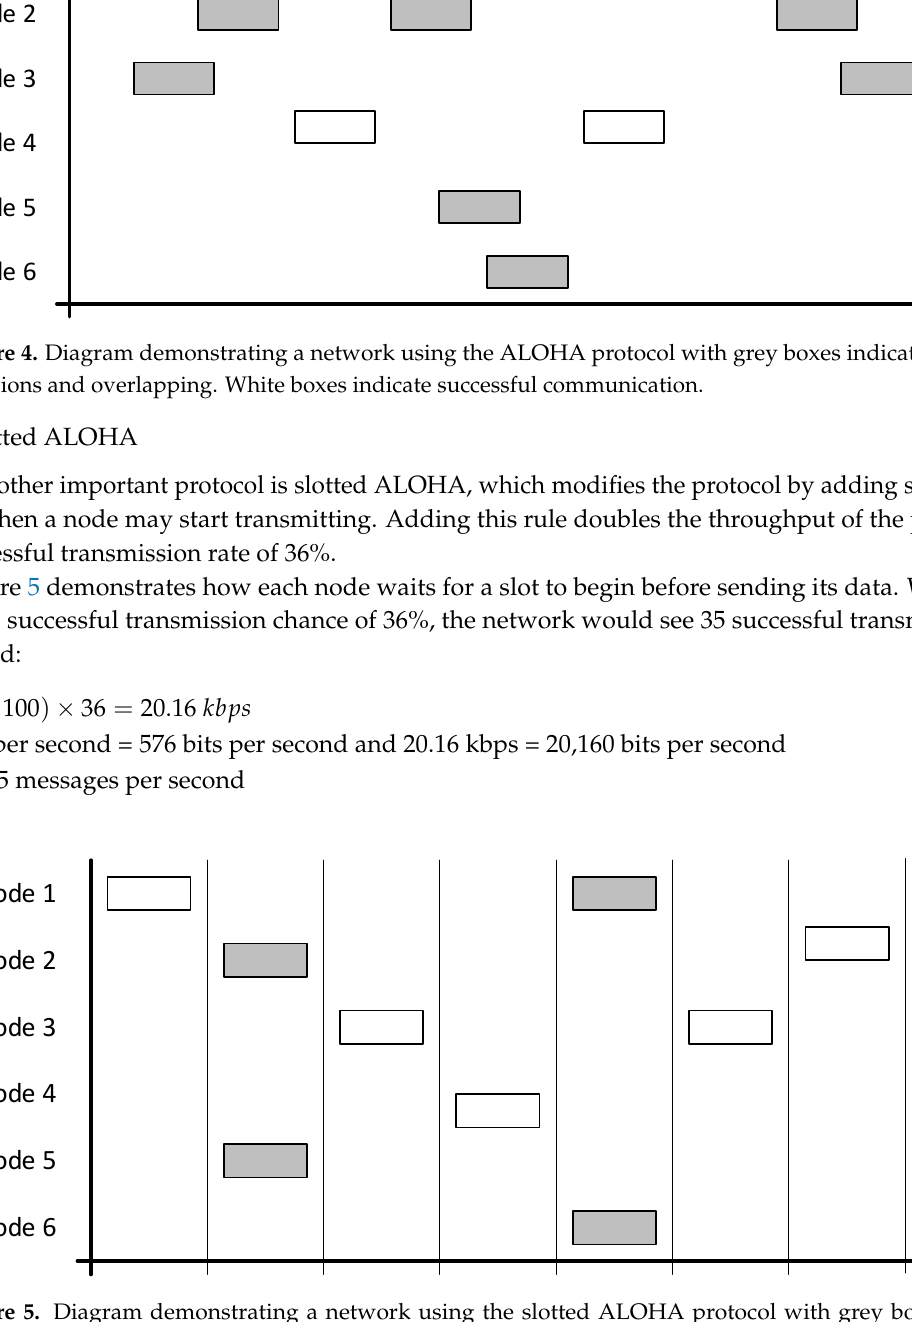
Figure 5. Diagram demonstrating a network using the slotted ALOHA protocol with grey boxes indicating collisions and overlapping. White boxes indicate successful communication.